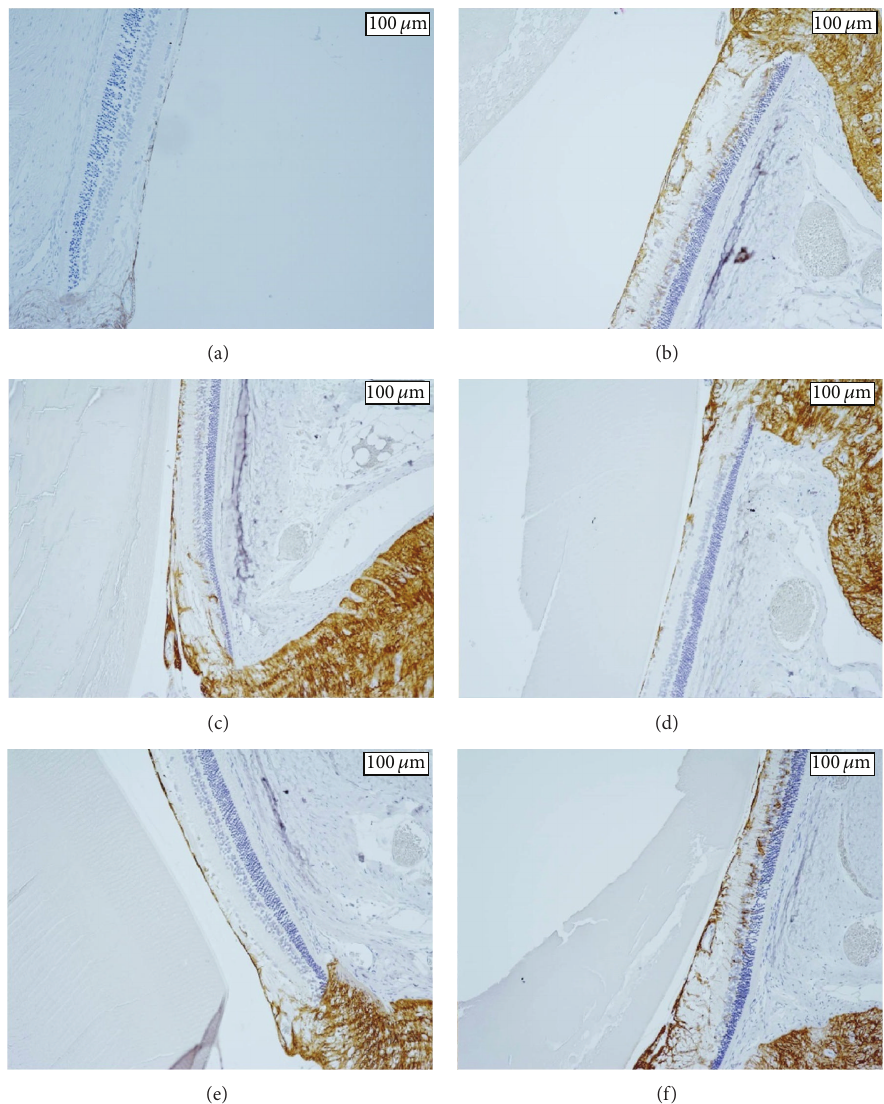
Figure 5: (a) The retina in a 31-week-old untreated SDT rat. The area of stained GFAP is significantly smaller in 31-week-old untreated SDT rats than in untreated SDT rats older than 50 weeks, but there is no significant difference in retinal thickness. (b) The retina in an untreated SDT rat older than 50 weeks. The retina is thicker and the area of stained GFAP is larger compared with the normal SD rat. GFAP is strongly stained from the ILM to around the INL in the untreated SDT rats. (c) The retina in a ranirestat-treated SDT rat (0.1mg/kg/day). The retina is thinner and the area of stained GFAP is smaller compared with the untreated SDT rat. The stained area, which appears between the ILM and around the INL in the untreated SDT rats, is suppressed. (d) The retina in a ranirestat-treated SDT rat (1.0mg/kg/day). The effect of ranirestat (1.0mg/kg/day) is stronger than ranirestat (0.1mg/kg/day) on the retinal thickness and the area of stained GFAP. (e) The retina in a ranirestat- treated SDT rat (10mg/kg/day). Although the area of stained GFAP in the ranirestat-treated SDT rat (10mg/kg/day) is suppressed compared with the ranirestat-treated SDT rat (0.1mg/kg/day), the difference in retinal thickness is not clear. (f) The retina in an epalrestat-treated SDT rat. Epalrestat does not suppress the retinal thickness or the area of stained GFAP. The area of GFAP is intensely stained between the ILM and around the